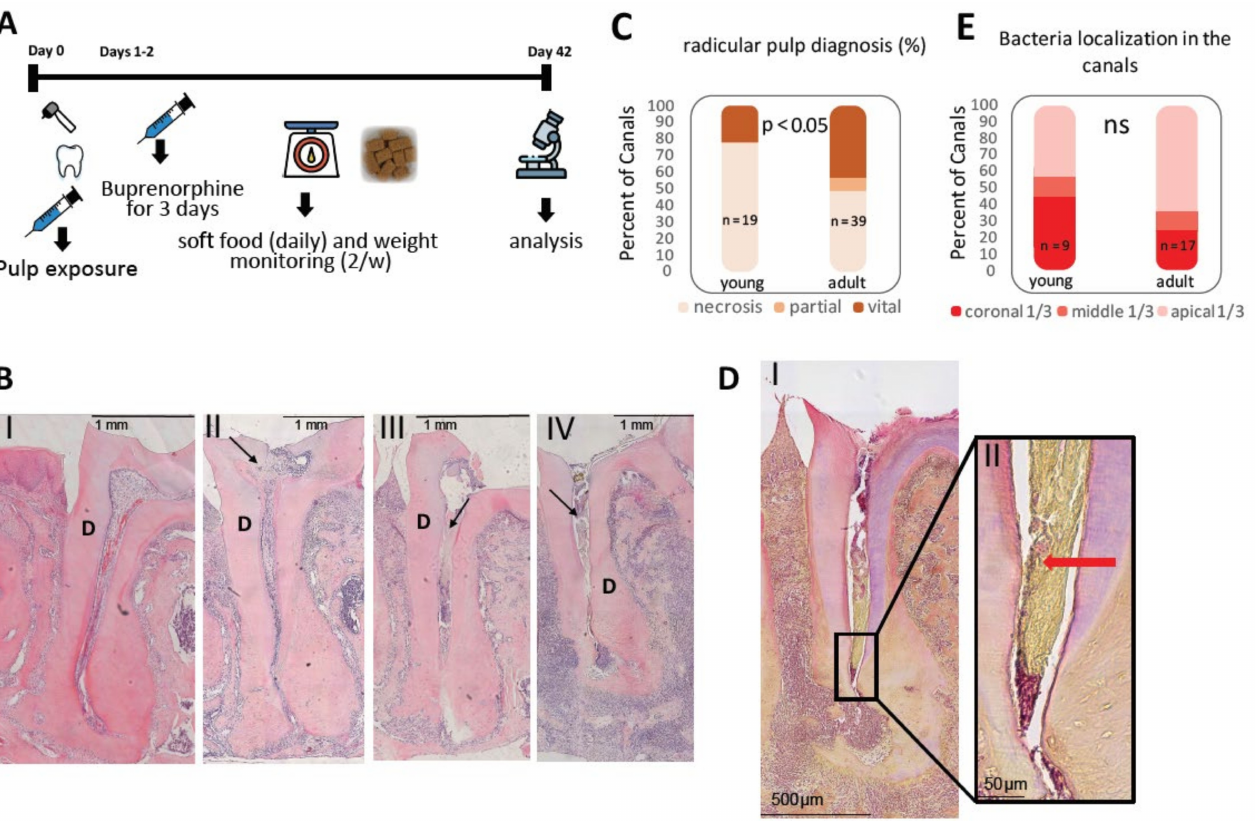
Figure 1. Experimental setup. ( A ) Scheme of experiment on a time scale. The experiments began with mesial and distal pulp exposure on the 1st mandibular molar unilaterally. The contralateral tooth was left as a control. To reduce pain, buprenorphine was injected to the animals for 3 days. The animals were left for 42 days, to develop the periapical lesion. During this time-course the animals received soft food daily and were monitored for weight loss. After 42 days, the animals were euthanized, and their jaws and teeth were removed and processed for analysis ( B ) H&E representative images of the different histological diagnosis in the root canals. D = dentin. I. control tooth with normal pulp diagnosis. II. tooth 42 days after pulp exposure presenting canal obliteration (arrow) and vital pulp. III. Partial necrotic canal. Coronal half of the canal presents necrosis (arrow), while apical half presents vital pulp. IV. Necrotic canal (arrow) ( C ) pulp diagnosis (%). percent of the canals after pulp exposure with the different pulp diagnosis, comparing the young and adult groups. p value < 0.05 by fisher test, comparing vital pulp to partial or necrotic pulp ( n = 19 (young), 39 (adult)). ( D ) Representative Brown and Brenn image of bacteria in the apical 1/3 of an infected canal (I). The area enclosed in the black rectangle is an enlarged in image (II) where the bacterial biofilm can be seen as small blue dots near the canal wall (red arrow). ( E ) Localization of bacteria in the canals. The bar graph presents the percent of canals (out of all the canals excluding canals with vital pulp) with bacteria in the different locations of the canal. p value = 0.41 (fisher test), comparing the coronal 1/3 to the apical and middle 1/3 ( n = 9 (young), 17